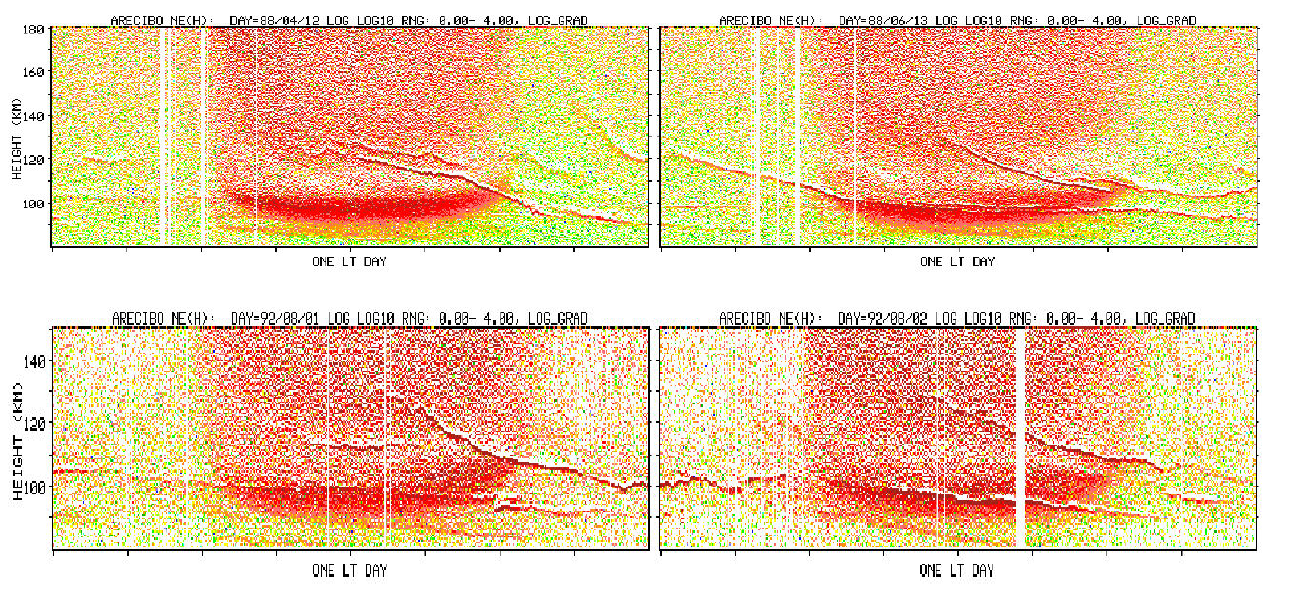
Fig. 3. Typical log (dN e /dz) HTI plots used in the present study for identifying the different E s layers prevailing in the Arecibo data. These traces were first grouped and then digitized, so they could be statistically analyzed for every